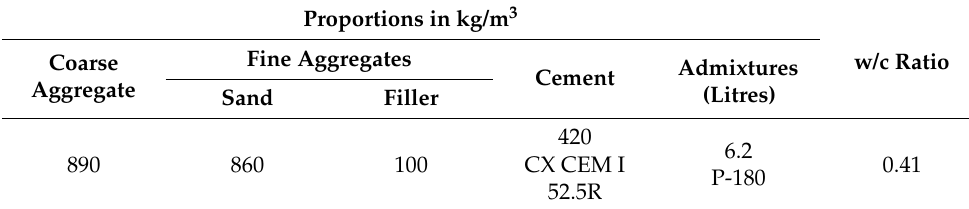
Table 5. Mix proportions for first-stage